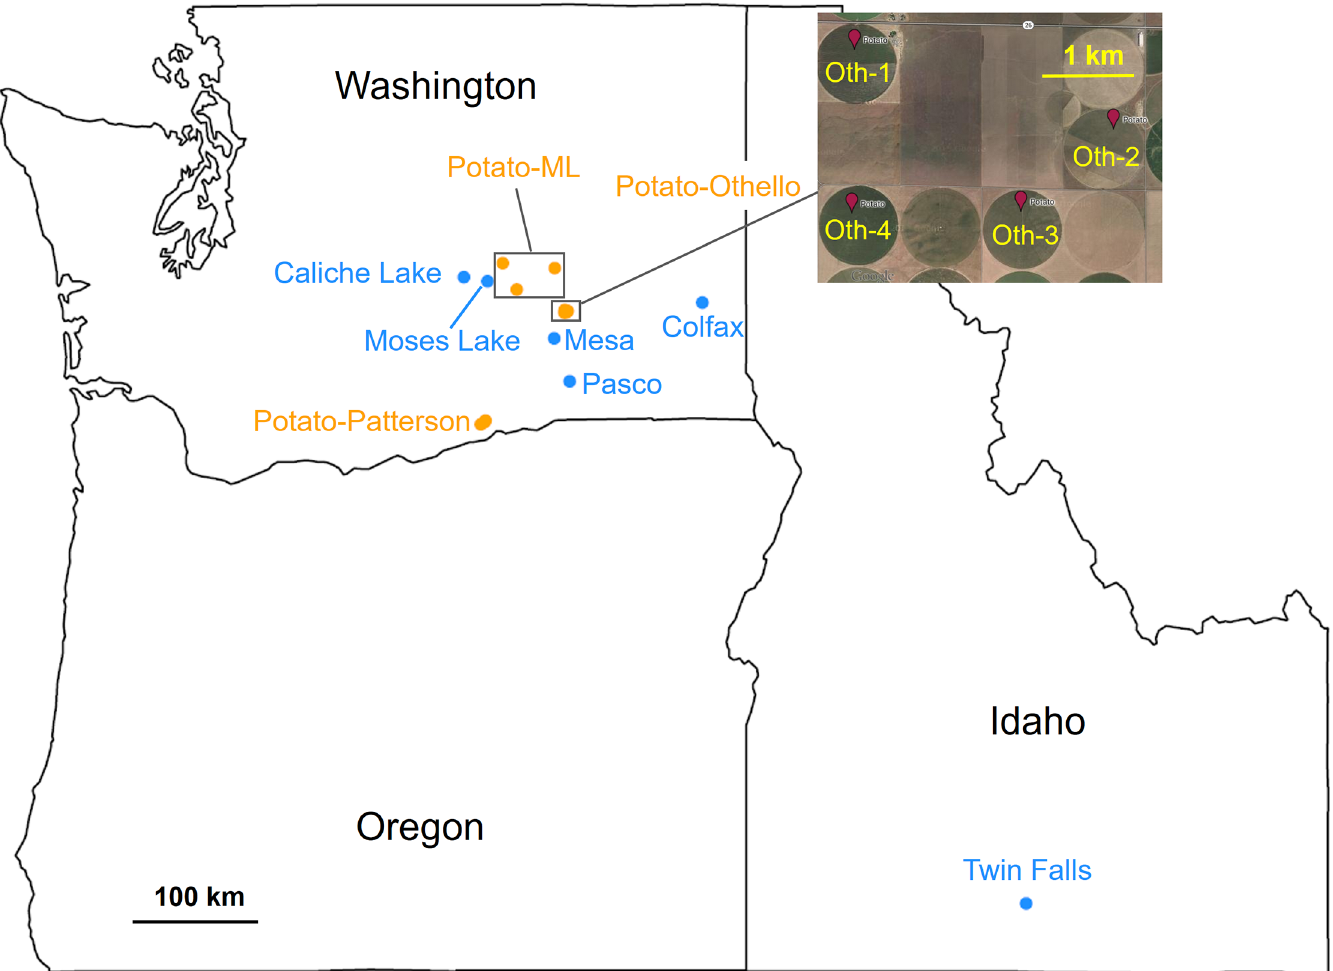
Fig 1. Potato psyllid collection sites across the states of Washington and Idaho, United States of America. Potato psyllidswere collectedfrom bittersweet nightshade patches (blue circles) or potato fields (yellowcircles). See Table 1 and S1 Table for detailedinformation about each population.